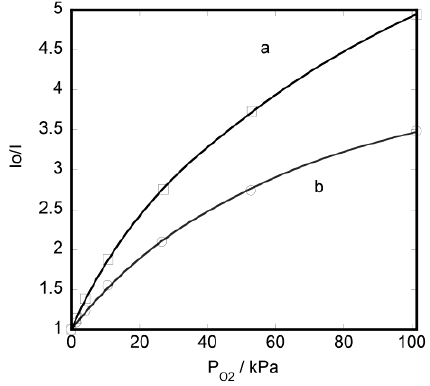
Figure 3. Stern-Volmer plots for quenching by oxygen molecules (a) {DFPPY/MON} and (b) {PPY/MON}. Curves were calculated with two site model (modified from reference [66]).